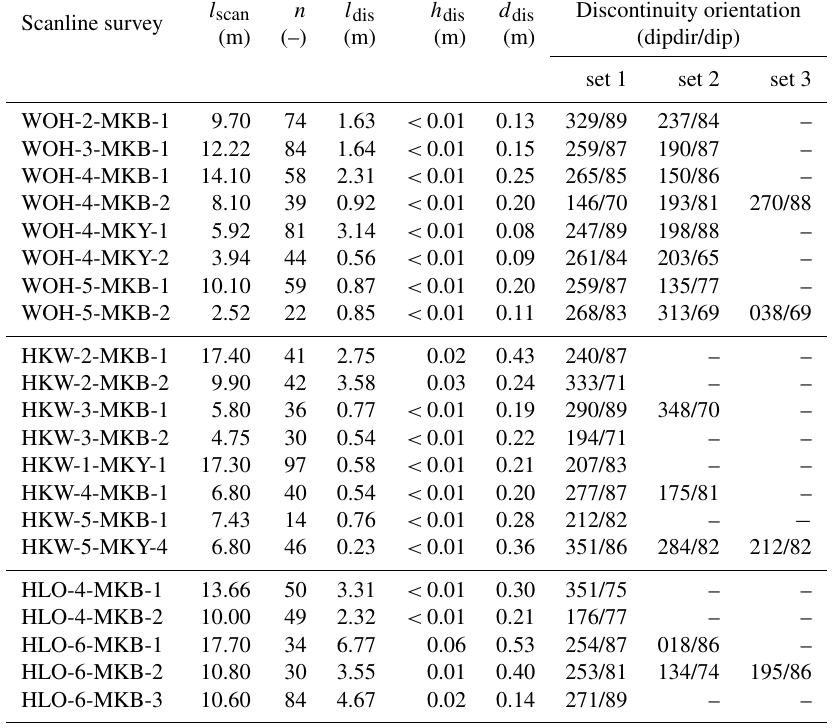
Table 3. Overview of the settings and the results of the scanline surveys performed on rock walls in the outcrops Wuppertal (WOH), Hagen- Hohenlimburg (HKW), and Hönnetal (HLO). The abbreviations MKY, MKB, and MKR correspond to the coloured rock types Massenkalk yellow (dolomite), Massenkalk black (limestone), and Massenkalk red (dolomite), respectively. Three main families or sets of discontinuity orientations were found to be predominant in all